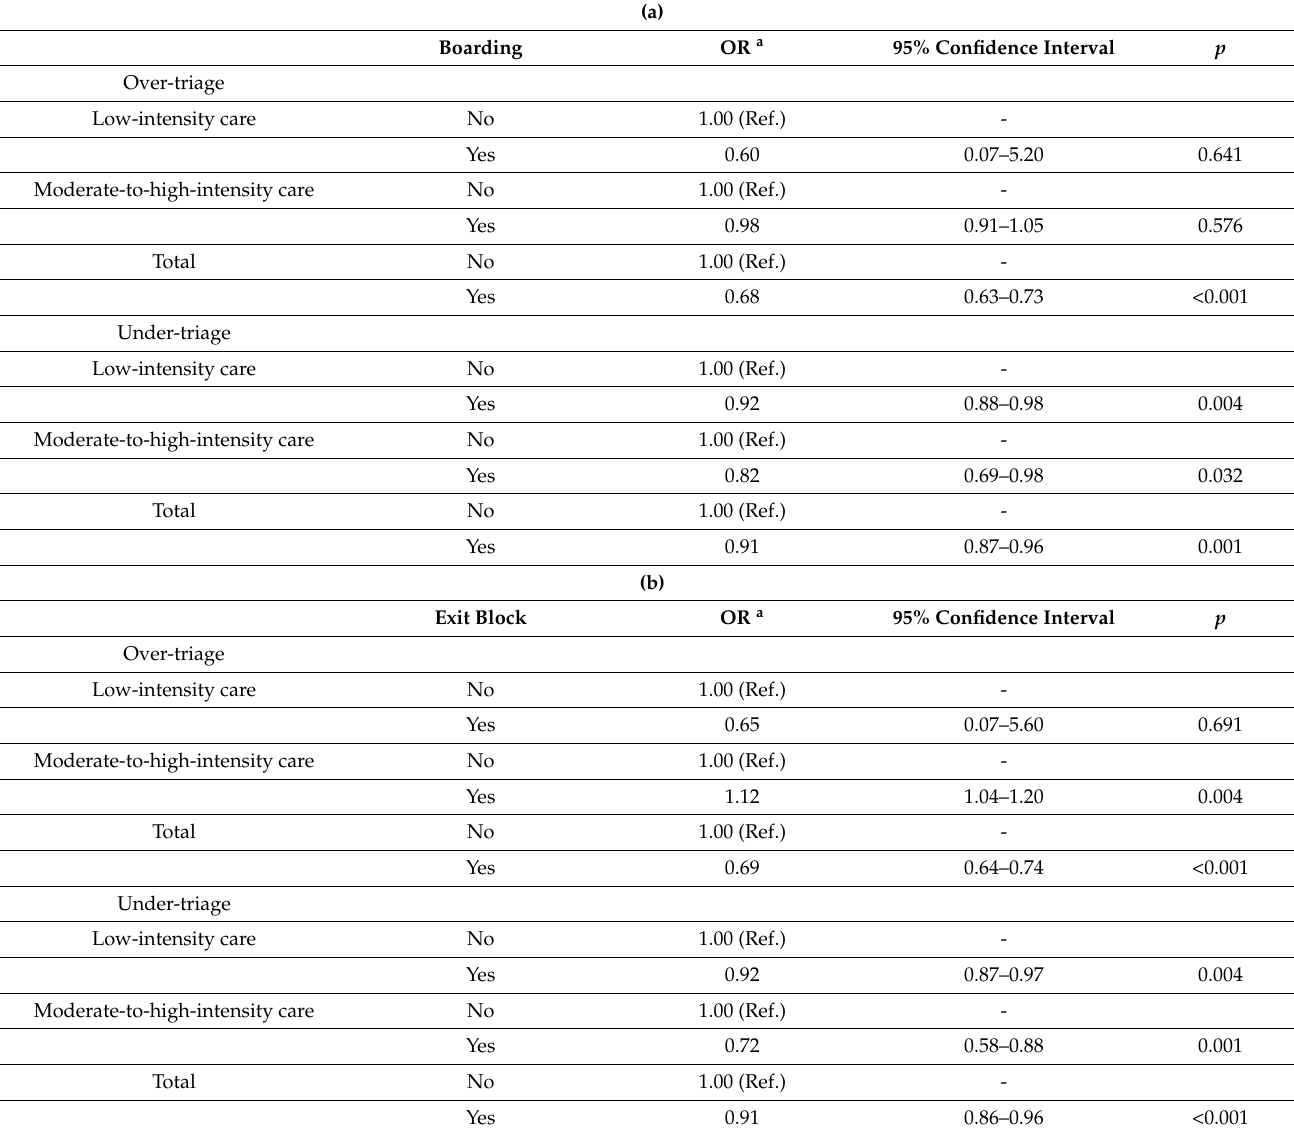
Table 5. ( a ) Risk of UT and OT, by presence of boarding. ( b ) Risk of UT and OT, by presence of exit